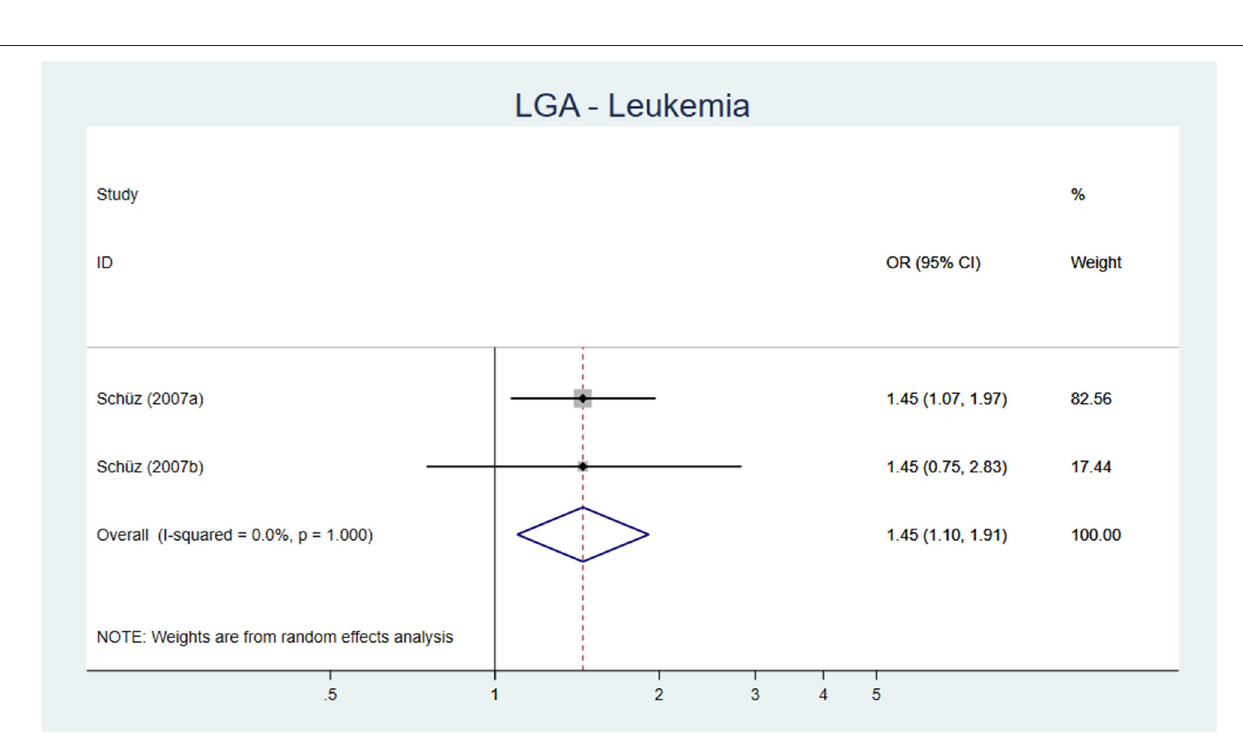
FIGURE 6 | Forest plot describing the association between LGA and